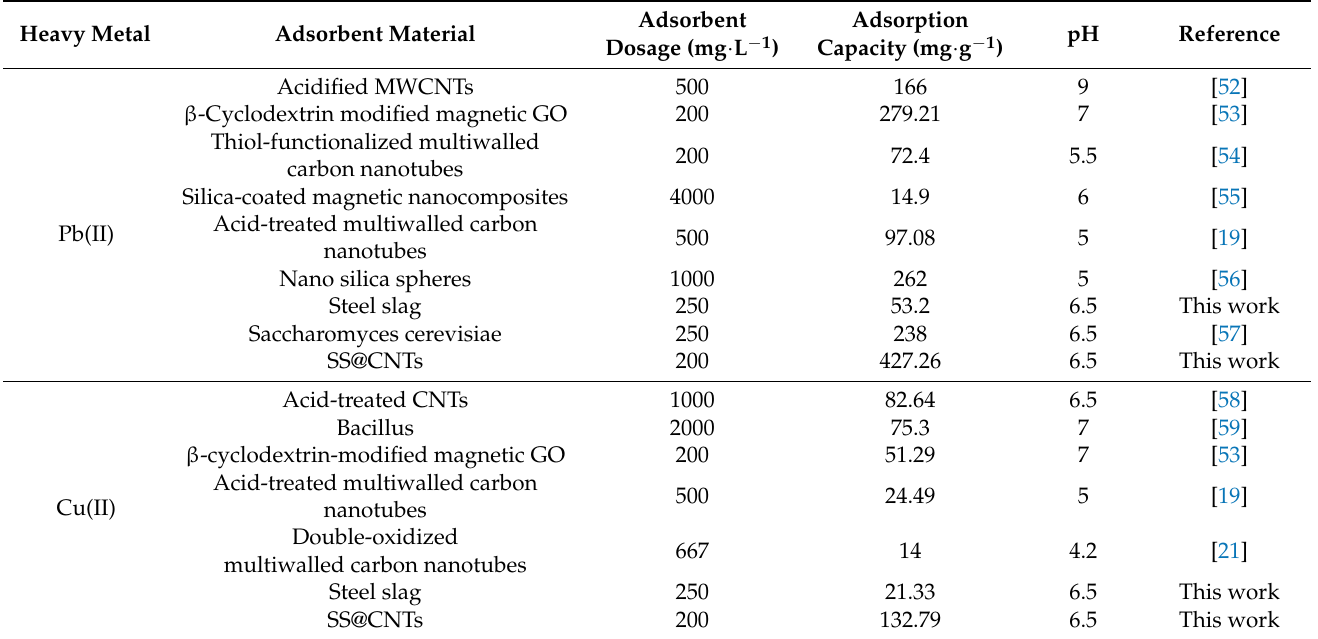
Table 11. Comparison of the uptake of lead and copper ions by various